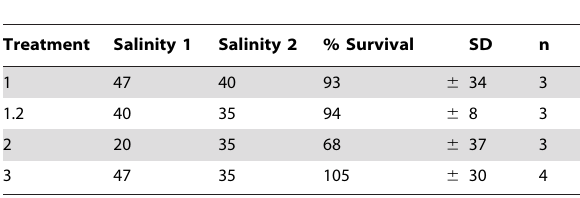
Table 2. Percentage polyp survival during salinity fluctuations (Experiment C).